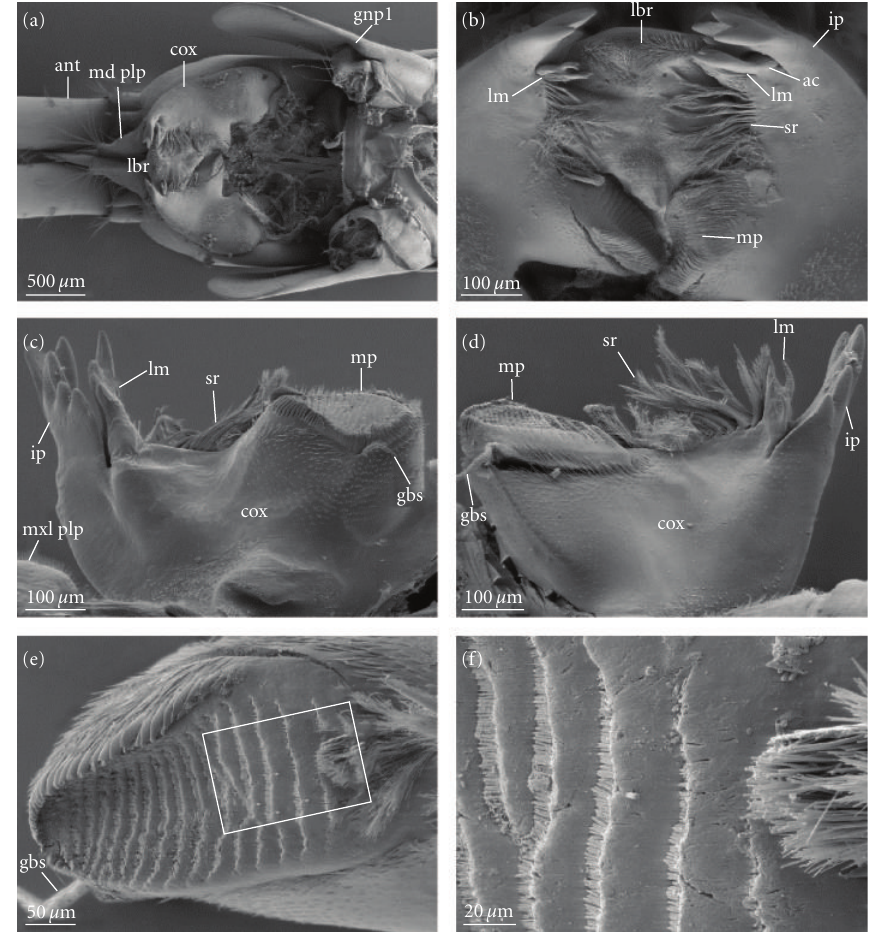
Figure 14: SEM images of mandibles of Gammarus pulex : (a) ventral view of head with exposed mandibles; maxillulae, maxillae, maxillipeds, and gnathopods removed; (b) coxa of mandibles in situ in posterior view; (c) coxa of left mandible in anterior view; (d) coxa of right mandible in anterior view; (e) molar of right mandible in median view; rectangle indicates close-up image in (f); (f) closeup of molar surface of right mandible in median view (cf. (e)). Abbreviations other than in previous figures: ant: antenna; gbs: gnathobasic seta; gnp1: first